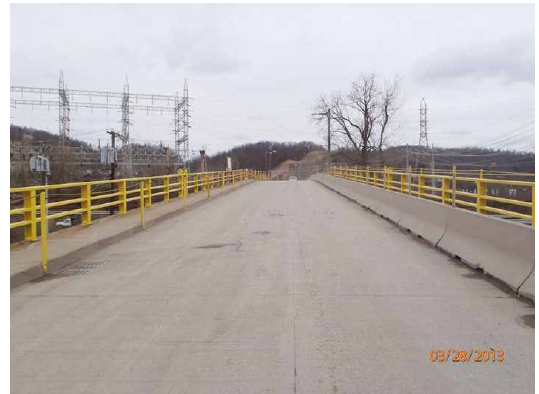
Figure 6. Access road bridge deck at Cardinal plant